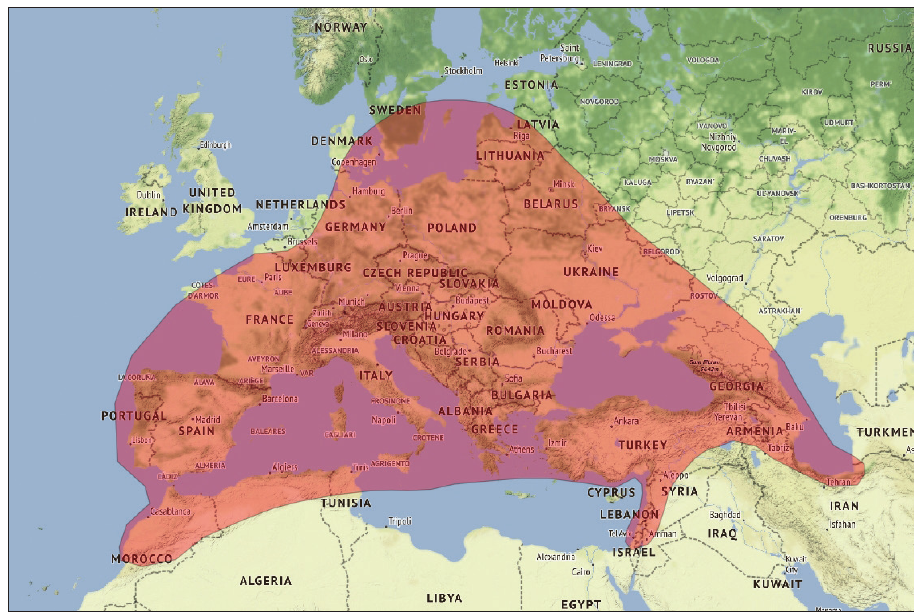
Figure 1. Distribution map of Cerambyx cerdo based on data from the IUCN (background map from Stamen Design,